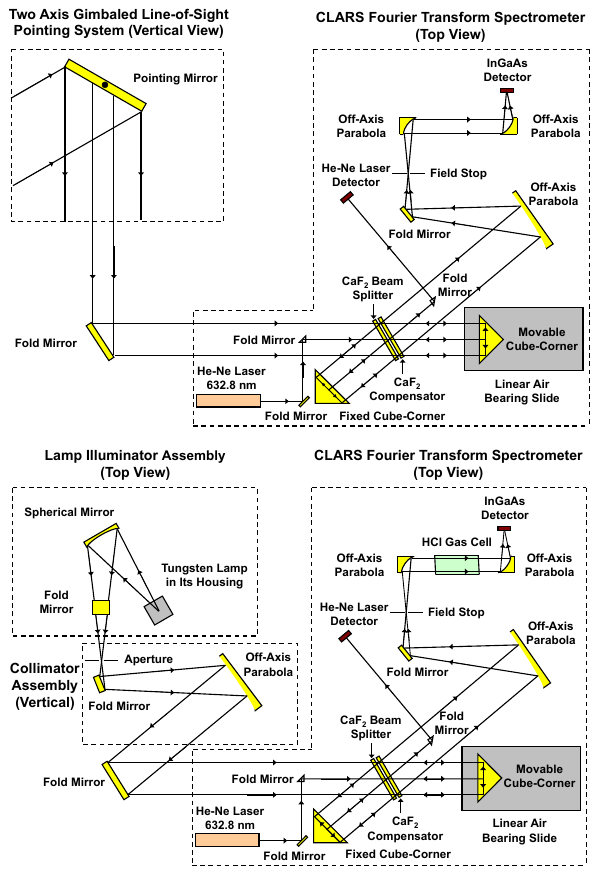
Figure 1 . Optical layouts of California Laboratory for Atmospheric Remote Sensing Fourier Transform Spectrometer (CLARS-FTS) for measuring greenhouse gases (top panel), and gas cell spectra to verify instrument alignment quality and stability (bottom panel). The core is a Michelson-type interferometer using cube-corner retro reflectors. It covers a spectral range of 4000 to 15000cm − 1 with a maximum optical path difference (MOPD) of 30cm (or spectral resolution of 0.02cm − 1